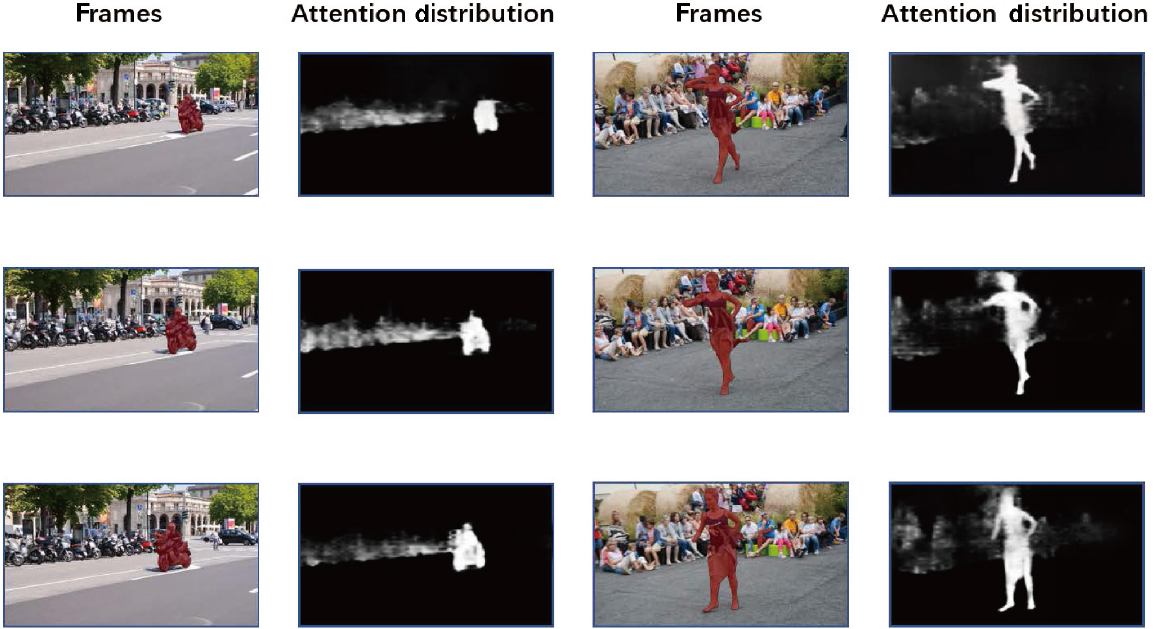
Fig. 5 Attention maps generated by the spatial constraint